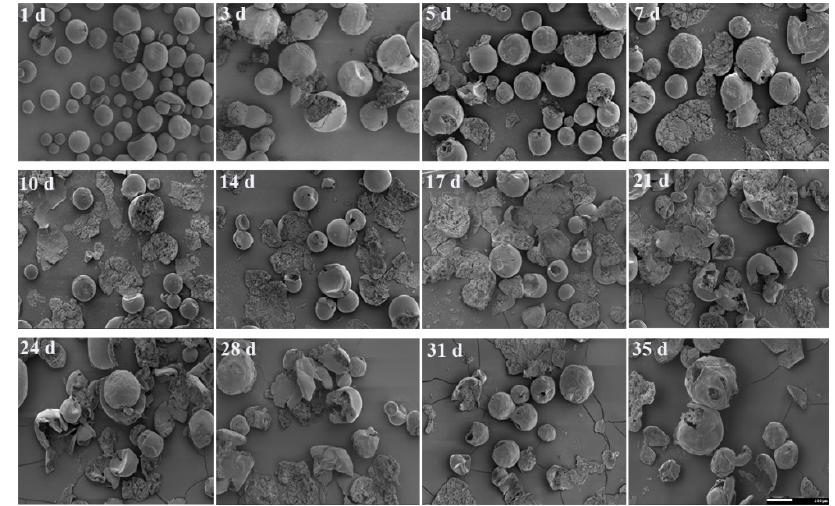
Figure 10. Degradation of Vivitrol ® during in vitro release observed by SEM.